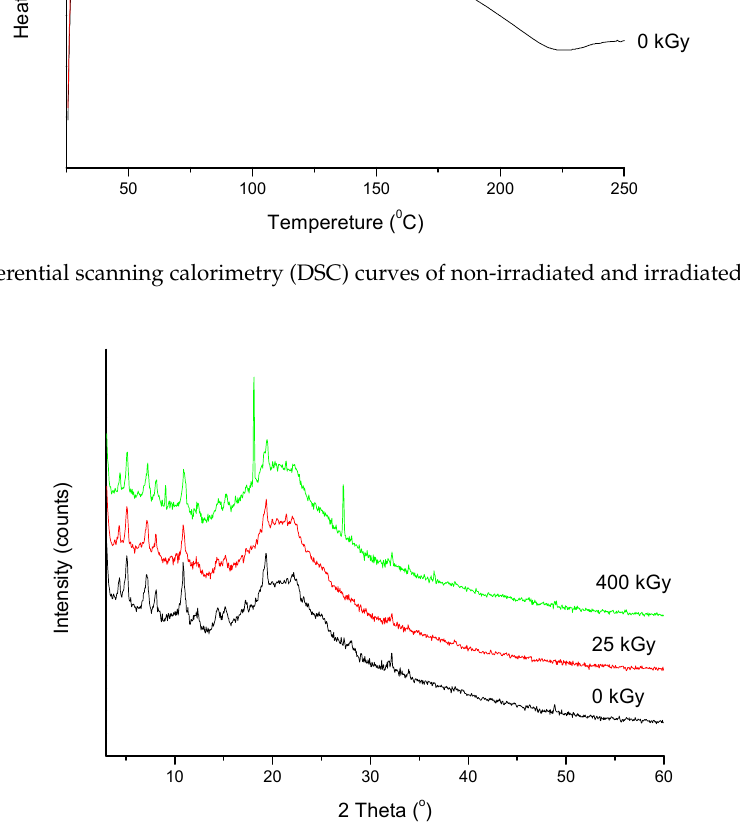
Figure 6. X-ray powder di ff raction (XRPD) spectra of non-irradiated and irradiated